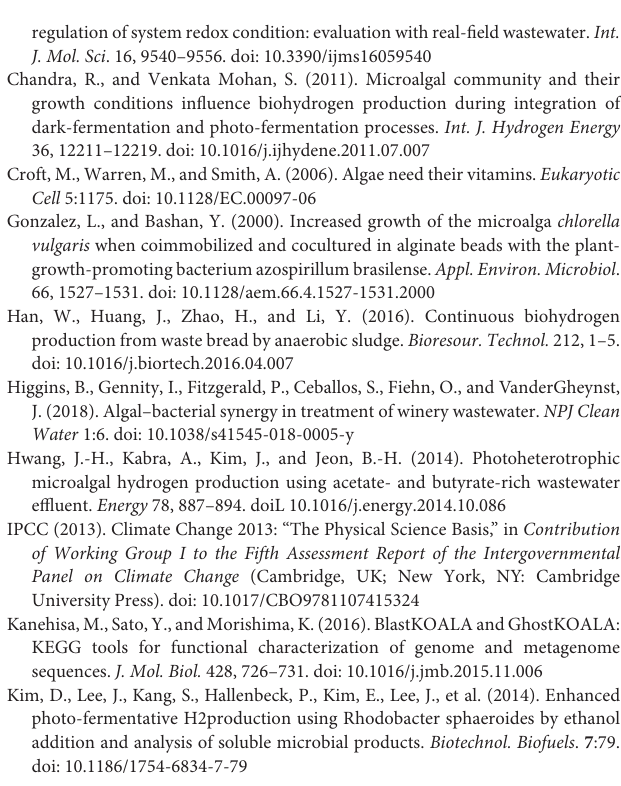
Supplementary Table 1 | Results of Tukey HSD test comparing different samples for daily Hydrogen production. Supplementary Image 1 | GC distribution for the 3 bacterial